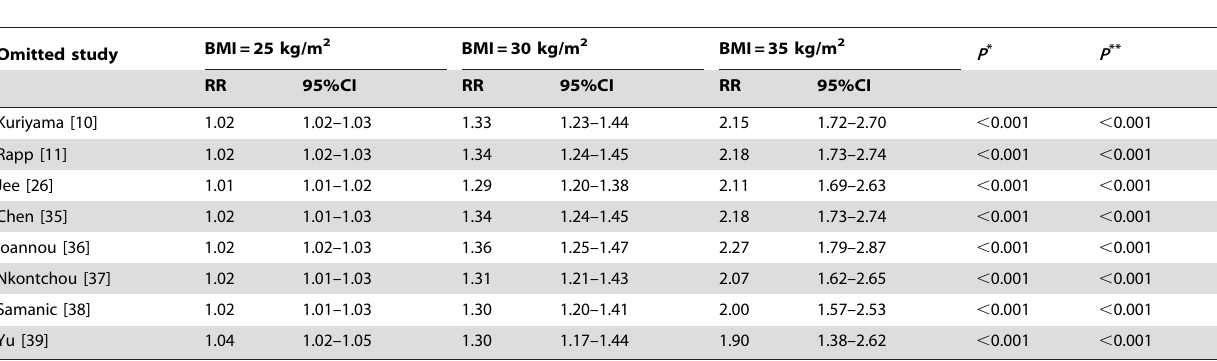
Table 2. Relative risk with 95% CI of body mass index (kg/m 2 ) at point of 25, 30 and 35 in comparison with reference (median value of lowest category) by omitting each article in sensitivity